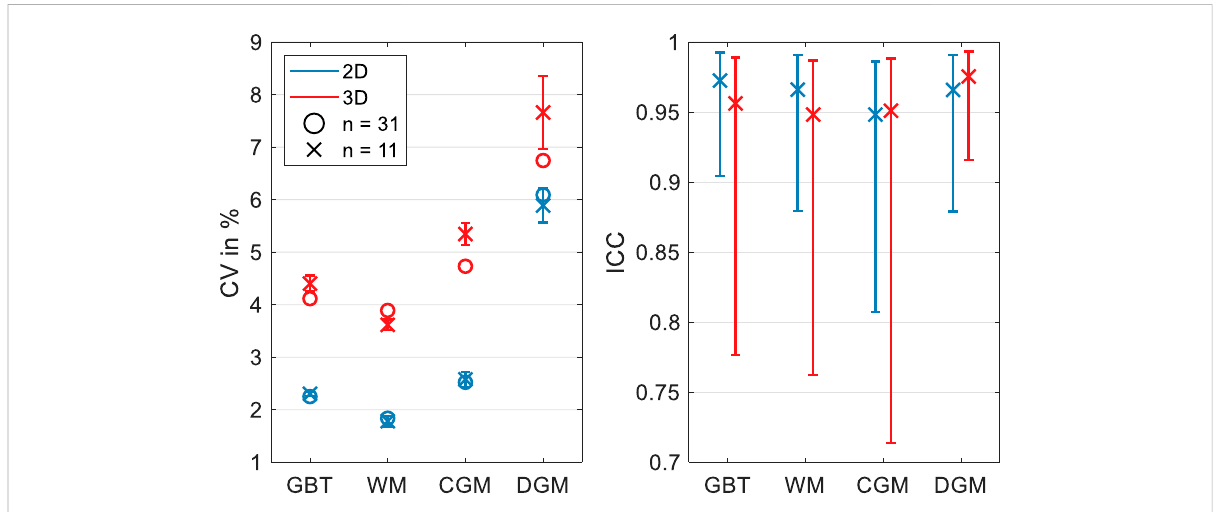
FIGURE 7 Coef fi cient of variation (CV, left) and intraclass correlation coef fi cient (ICC, right) for 2D and 3D SWS reconstructions for global brain tissue (GBT), white matter (WM), cortical gray matter (CGM), and deep gray matter (DGM). CV determined from single examination of all volunteers and as an average from three CVs in eleven volunteers examined at baseline, 1 day later, and after 1 year. ICC was determined from baseline and repeated examination after 1